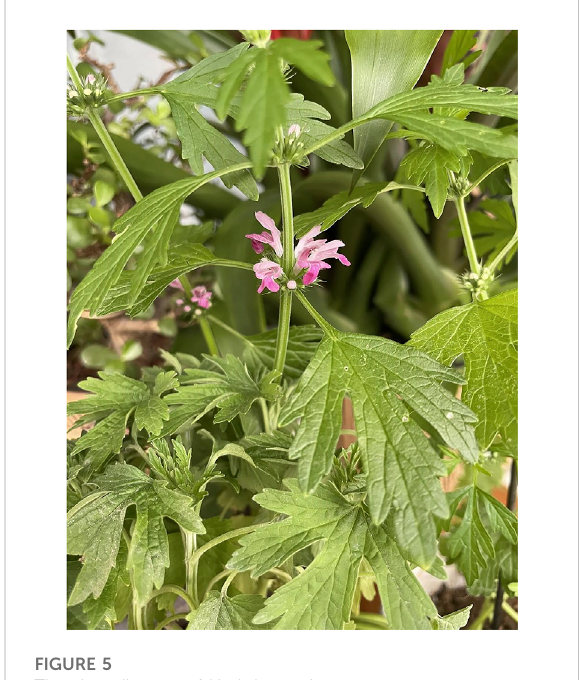
FIGURE 5 The plant diagram of Herb Leonuri .